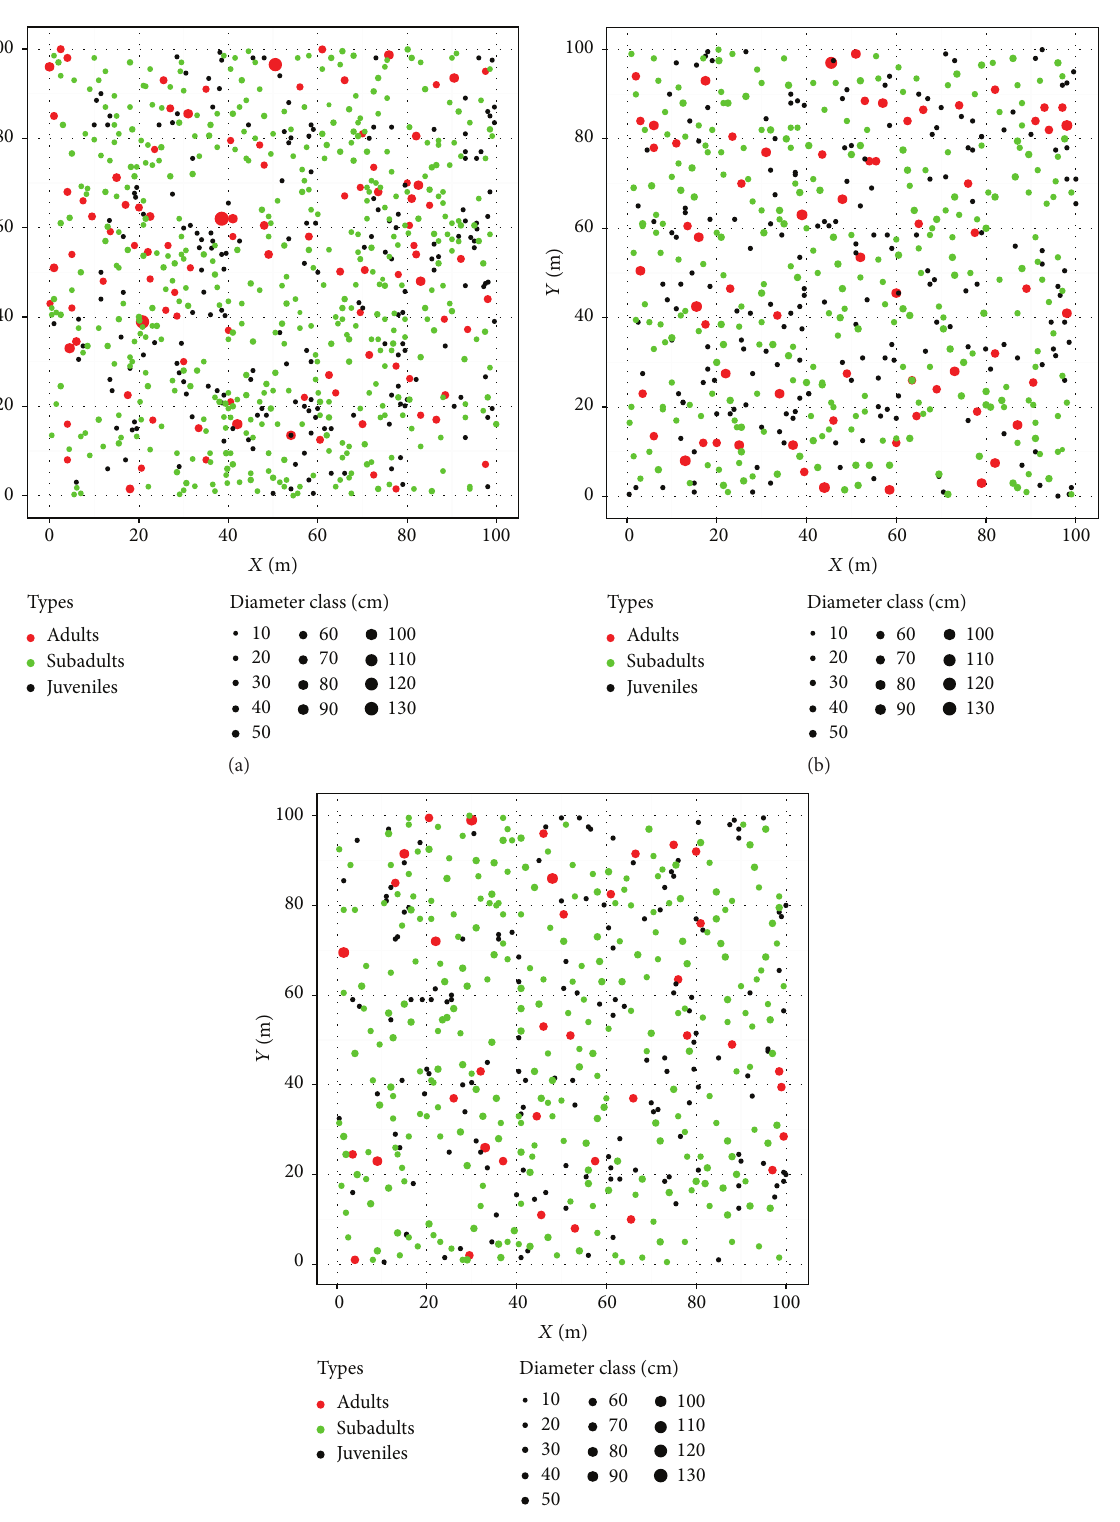
Figure 3: Distribution of all tree individuals in the three life stages: “juveniles,” “subadults,” and “adults.” Symbol size is proportional to the DBH of the individuals with an actual size from 6.0 to 129.2 cm. The unit of ( 𝑋, 𝑌 ) axes is meter, where (a) is the undisturbed forest, (b) the lightly disturbed forest, and (c) the highly disturbed